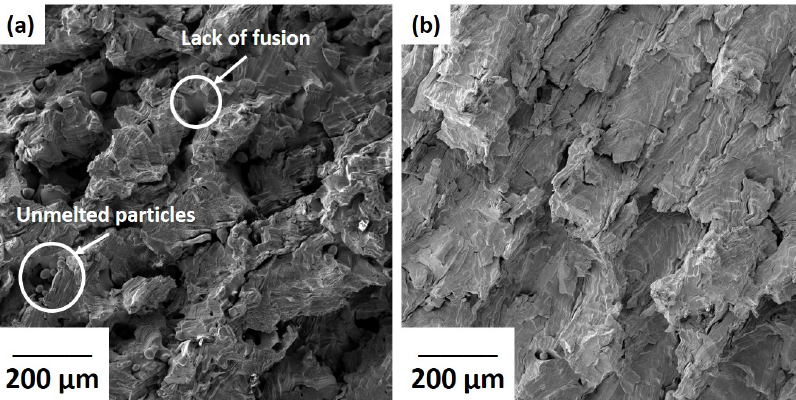
Figure 9. SEM images of fracture surfaces for ( a ) pure molybdenum and ( b ) Mo-0.1SiC printed at 400 mm/s.